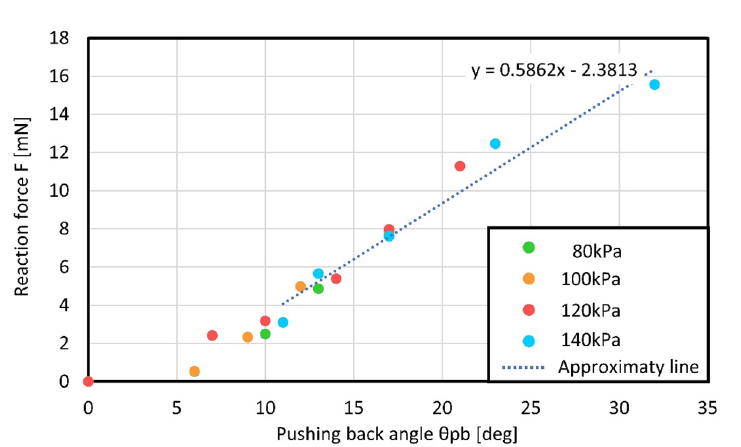
Figure 8. Force measurement principle for active sensing by a microfinger. ( a ) Microfinger approaching a pill bug. ( b ) Interaction with a pill bug. ( c ) Expected force corresponding to the applied pressure based on the obtained relationship. ( d ) Bending angle θ 1 obtained by the sensor signal. ( e ) Reaction force calculated using a difference of corresponding forces to θ 0 and θ 1 .